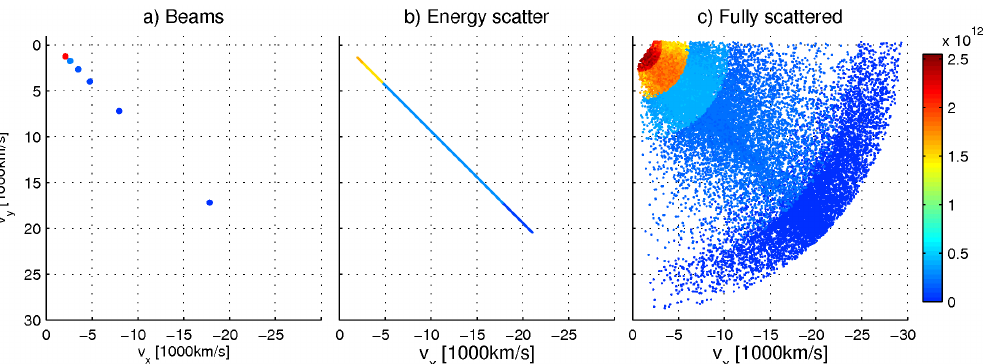
Fig. 3. Illustration of the incident upstream velocity distributions for the energetic protons tested in this paper. The dots correspond to macroparticles in the upstream SEP flow, with their colour corresponding to macroparticle weight. The energetic proton flux is modelled using three different initial velocity distribution functions for the high energy SW protons: (a) the beam distribution model with six energy beams corresponding to the SLED energy channels, (b) the energy scattered distribution model based on SLED data and (c) the fully scattered distribution model which includes both angular and energy scattering. The angular scattering is not known and in the runs it was assumed to be as shown in panel (c) . Note that in panel (c) the distribution of macroparticles within an ion population goes as ∼ E − 1 . 5 (applicable to panel (b) as well) and according to a Gaussian distribution in pitch angle, and therefore this is not a uniform